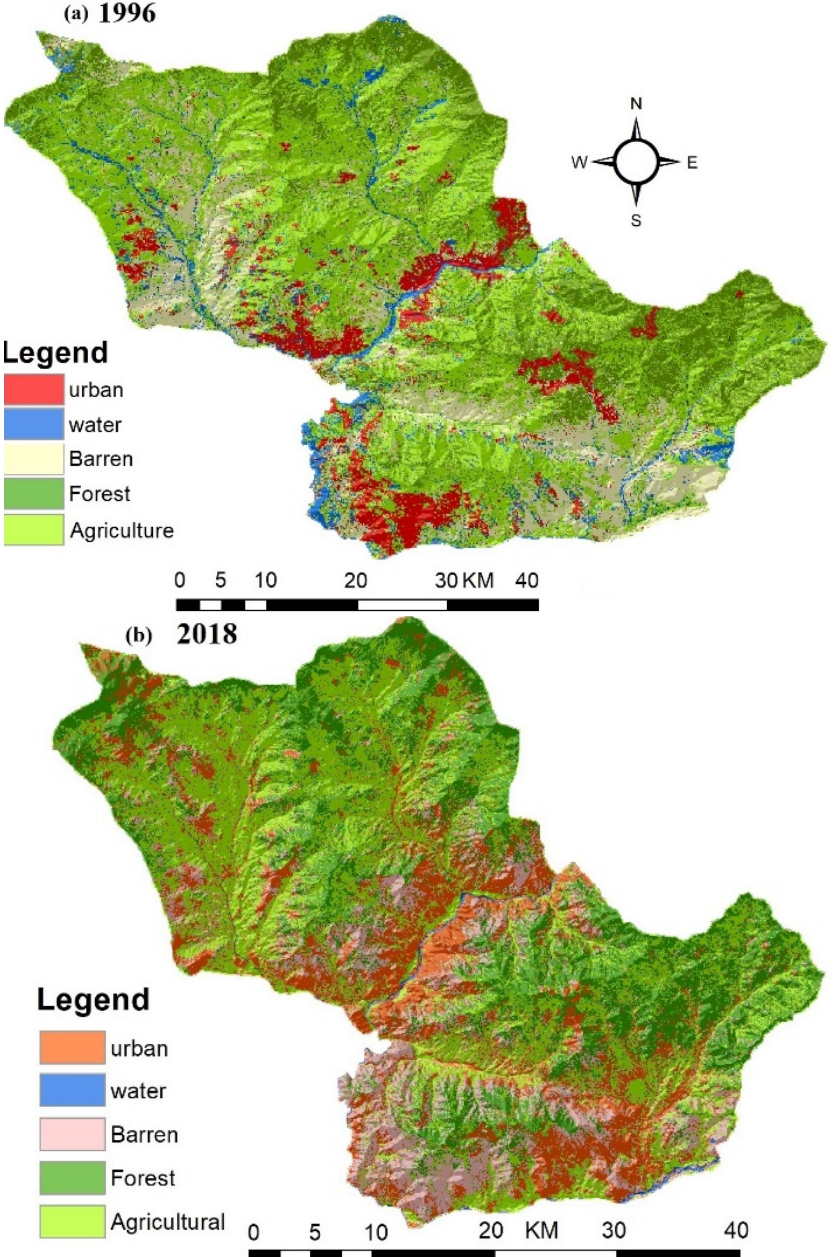
Figure 4. Temporal changes in land cover from ( a ) 1998 to ( b ) 2018. Table 3. Temporal changes in land use classes between 1996 and 2018 (expressed in%).